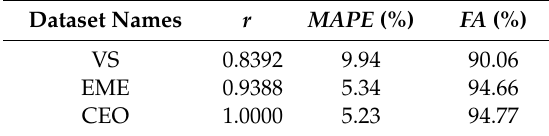
Table 5. Comparison of forecasting accuracy for the VS, EME, and CEO